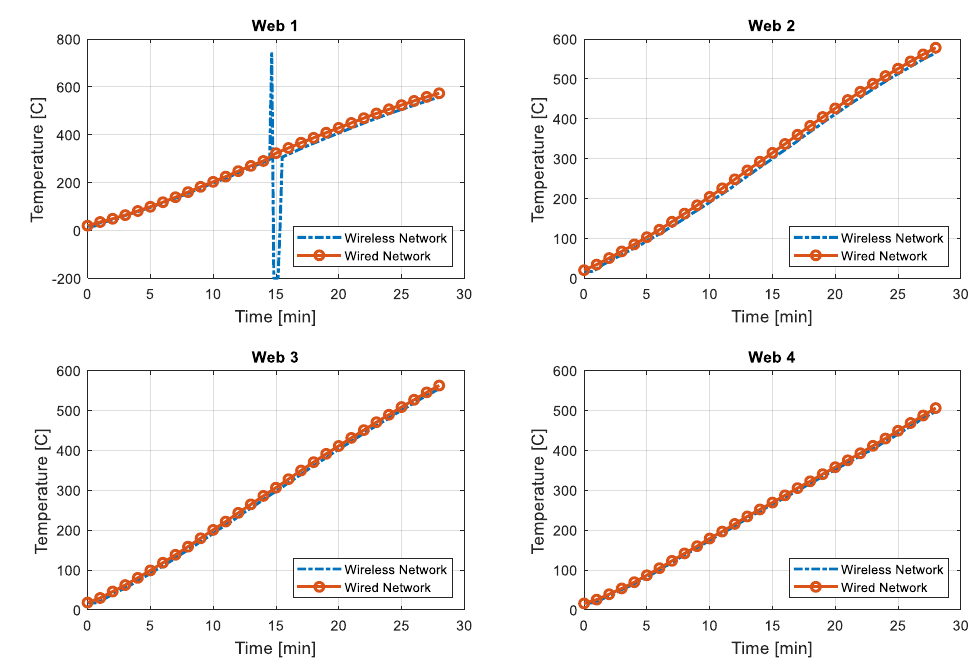
Figure 8. Temperature comparison for flange — first 28 min.